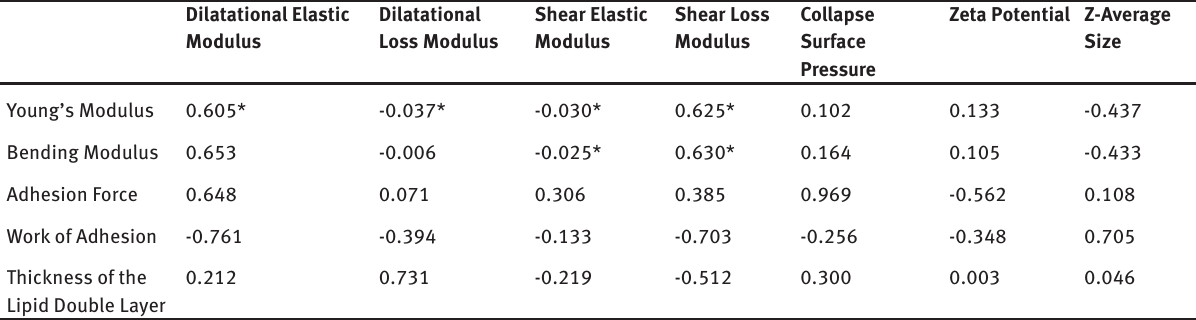
Table 4: Pearson correlation coefficients for the interfacial rheological properties of monolayer [21] and nanomechanical properties of